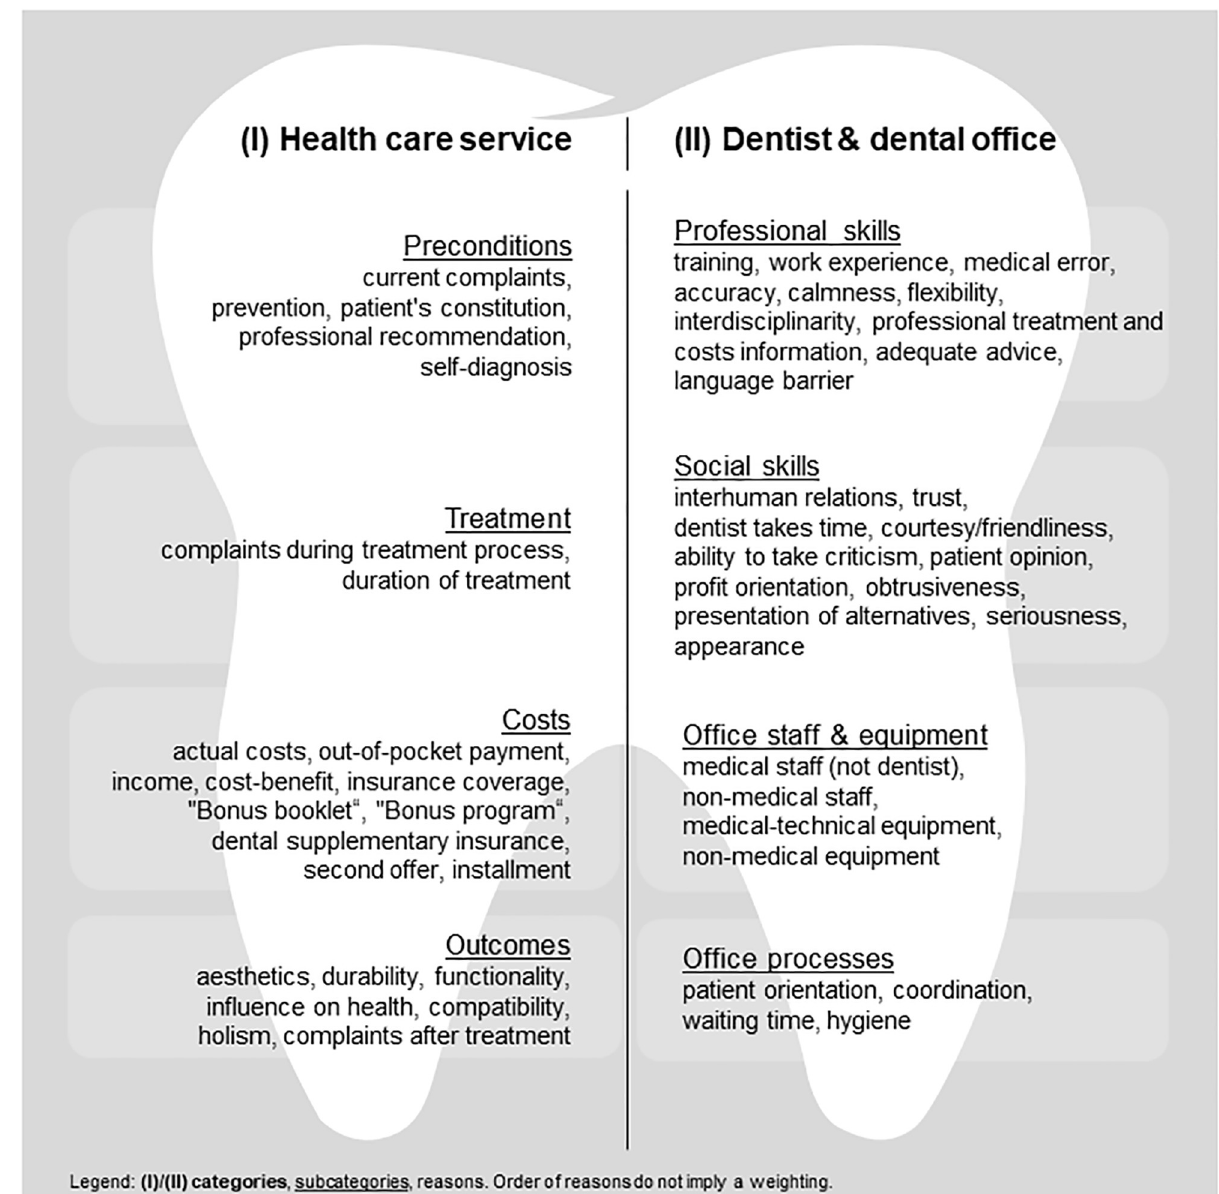
Fig 2. Reasons of choice regarding dental treatments from patients’ perspective classified in